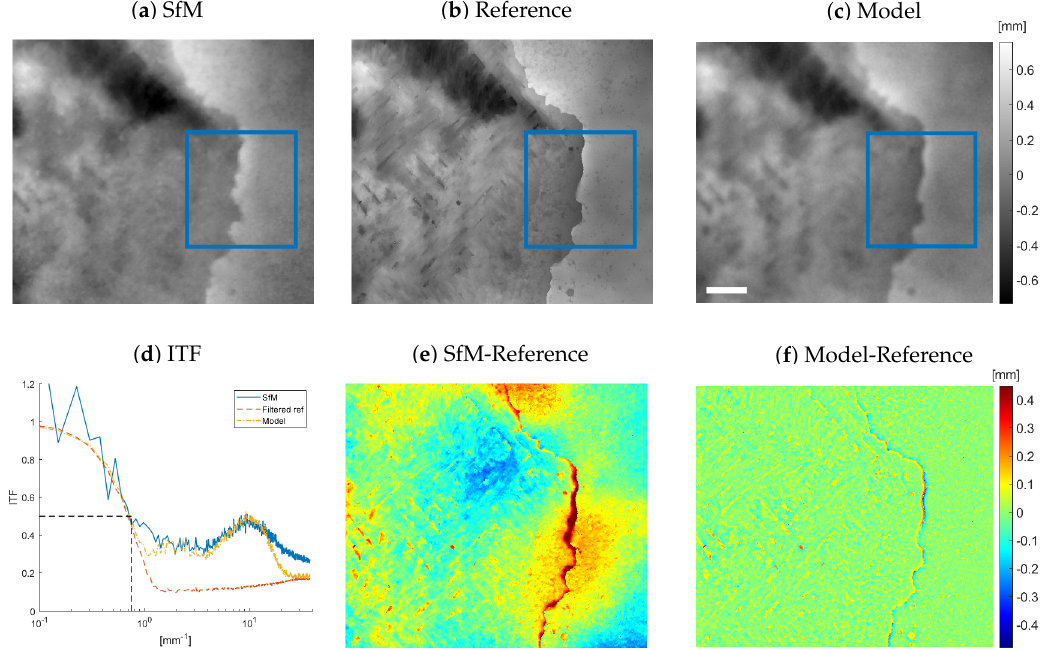
Figure 5. ( a ) Reference, ( b ) SfM and ( c ) model DEM of replication area R1. The blue box indicates the area used for the calculation of ITF50. The scalebar is 5 mm. ( d ) ITF for SfM and two model curves based on filtering the reference DEM with and without noise added. ( e , f ) Residual of SfM and model DEM with respect to reference